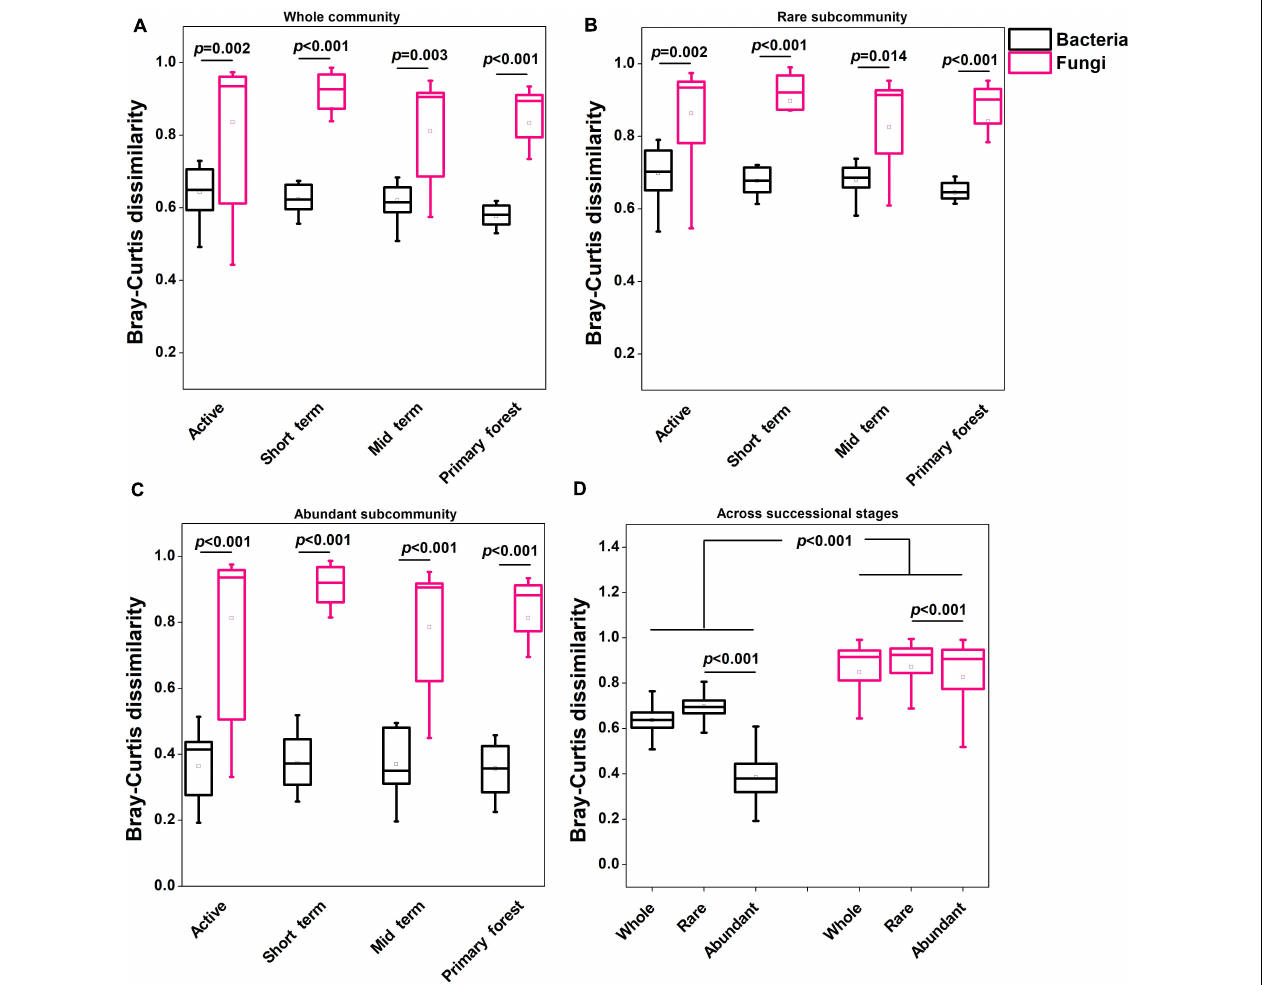
FIGURE 2 | Variation in microbial communities (A : Whole community; B: Rare subcommunity; C: Abundant subcommunity) within each successional stage and across all successional stages (D) based on weighted Bray–Curtis dissimilarity. The statistical significance was assessed by the Wilcoxon rank sum test. The square and horizontal black line inside the box represented mean and median, respectively. Data for the regionally abundant and rare OTUs in each stage and across all stages were used.